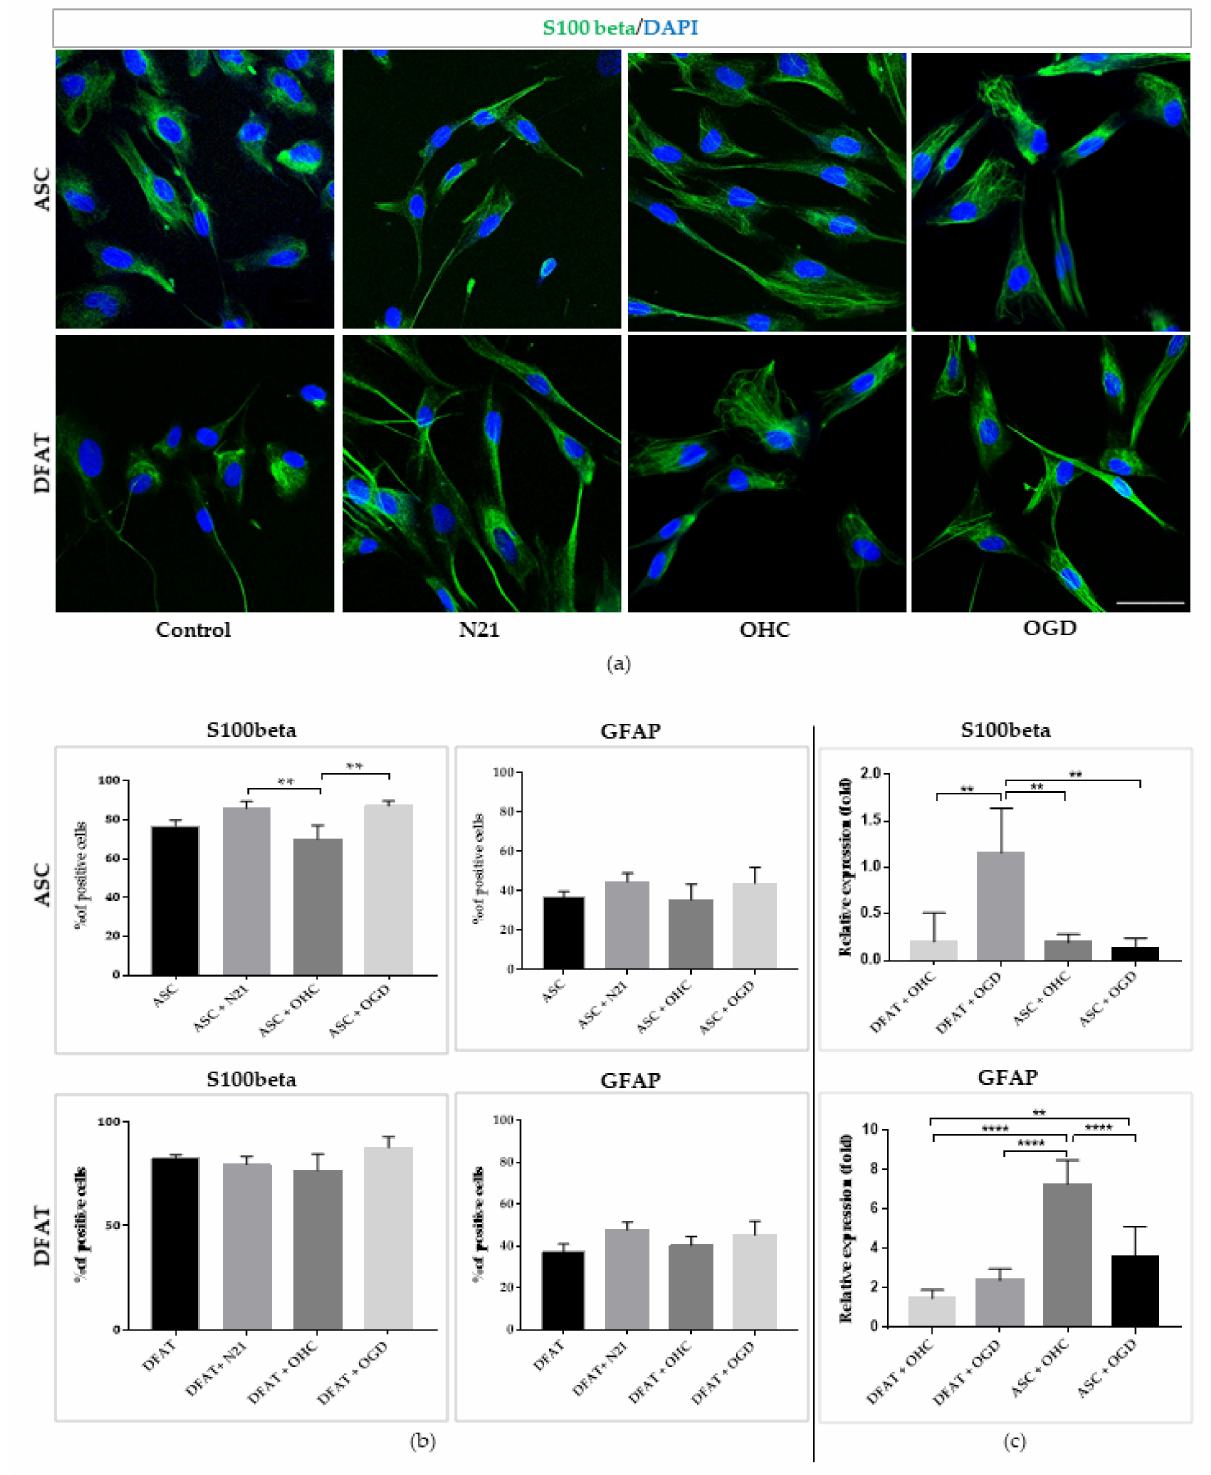
Figure 9. Astrocytic differentiation of ASCs/DFAT cells. S100beta, GFAP immunocytochemical/expression analysis. ( a ) Immunofluorescent images of ASCs/DFAT cells S100beta staining; ( b ) Quantitative analysis of astrocytic markers (GFAP, S100beta) presence in different culture conditions. ( c ) Astrocytic markers expression. The results are presented as mean values of three experiments ± SEM. The differences were considered statistically significant when p -value <0.05. Statistical significance level * for 0.01 < p < 0.05; ** for 0.001 < p < 0.01; *** for 0.0001 < p < 0.001; **** for p <